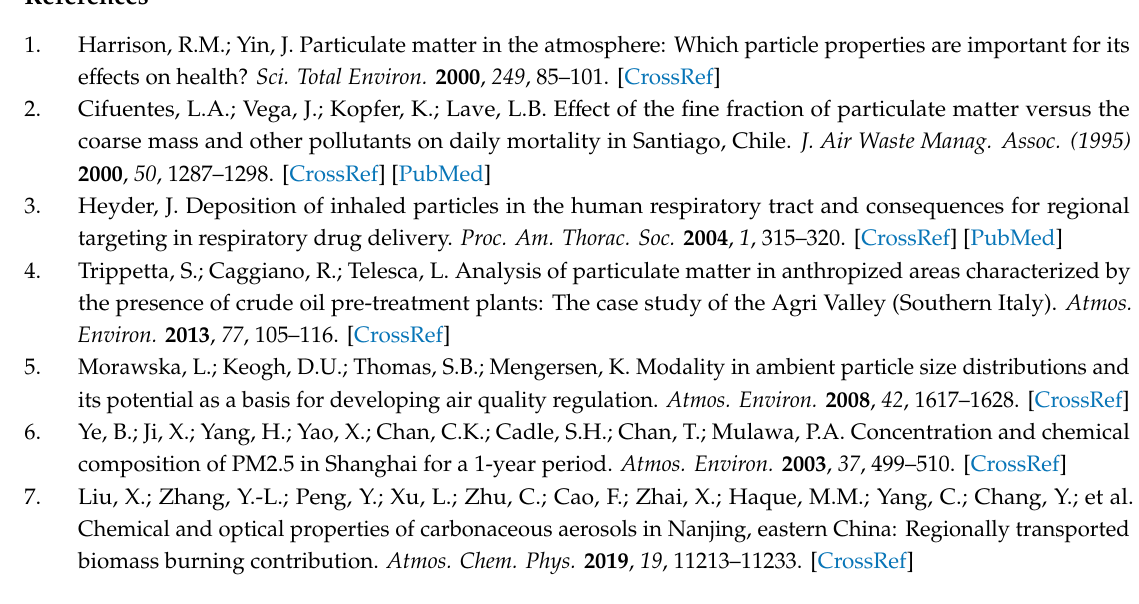
Figure S1: Mass concentration of PM 2.5 and meteorological conditions (wind speed and relative humidity) during sampling period, Figure S2: The backward air mass trajectories of 48 h starting form Xinxiang, (a) for PE1, (b) for PE2, (c) for PE3 and (d) for PE4, Table S1: Meteorological parameters during the sampling